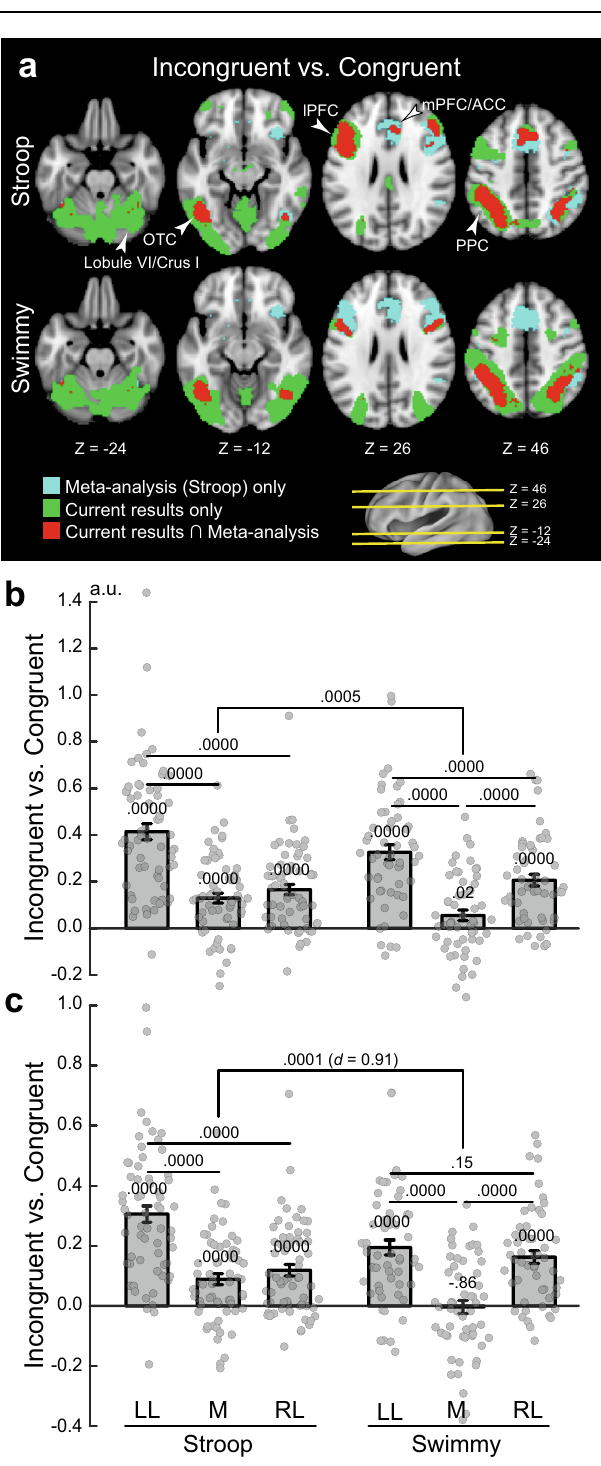
Fig. 7 | Stroop and Swimmy effects are compared with data from a large-scale meta-analysis.a Meta-analysismapsoftheStroopeffectandthecurrentactivation maps of interference effects (incongruent vs. congruent) are overlaid on the transverse sections ofstructural images. Stroop task(top);Swimmy task (bottom). Cyan: meta-analysis maps only; green: current maps only; red: both maps over- lapping. The levels of sections are indicated by Z levels at the bottom and yellow lines on the 3D surface of the brain at the right bottom. Arrowheads indicate anatomical locations. b ROI analysis (Stroop: N =63; Swimmy: N =55; independent participants).ROIswerede fi nedasleftlateral(LL),medial(M),andrightlateral(RL) regionsbasedon X axislevelsinthemeta-analysismapsoftheStroopeffect.Stroop task(left);Swimmytask(right).HorizontalandverticalaxesindicateROIsandbrain activity, respectively. Rectangular and error bars indicate means and standard errors of the mean across participants, respectively, with individual data overlaid oneachrectangularbar.Statistical p valuesareshownonthetop( t tests,two-tailed, uncorrected). c ROIanalysisinwhichROIswerede fi nedbasedonthemeta-analysis mapsofcognitivecontrol.Statisticalproceduresandformatsaresimilartothosein b . The sample size is identical to that in b